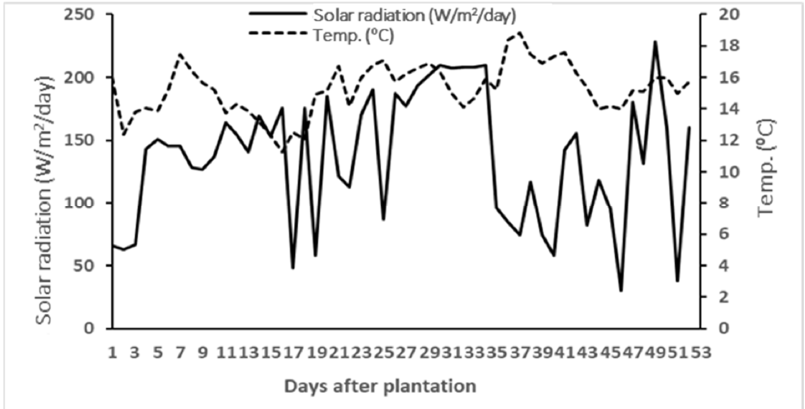
Figure 1. Average air temperature inside the greenhouse at plant level and solar radiation outside the greenhouse during the experimental period. Solar radiation data were obtained from an automated weather station located at Mitra research station